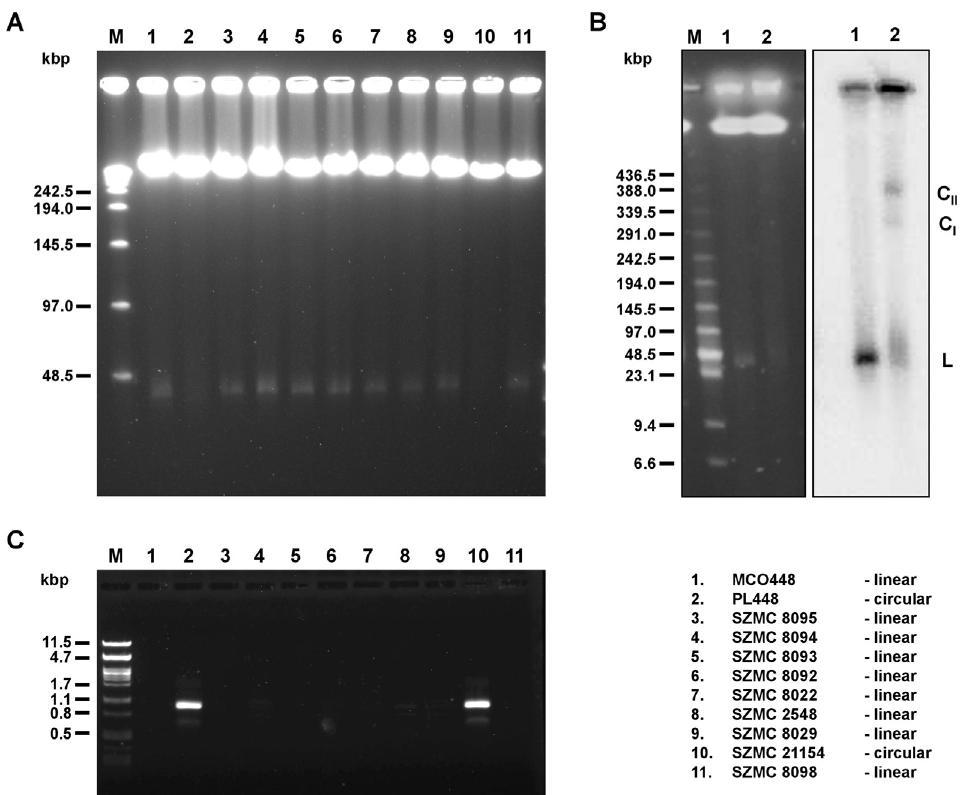
Fig 1. Linear and circular mitochondrial genomes in C . metapsilosis isolates. (A) PFGE analysis. DNA was isolated in agarose blocks and separated in PFGE as described in Materials and Methods. Only strains containing linear mitochondrial genome show a sharp band about 25 – 30 kb long. (B) Southern blot analysis. PFGE separated DNA samples were blotted onto a nylon membrane and hybridized with radioactively labeled mtDNA probe. The probe hybridizes with a sharp band (L) in the strain MCO448 with linear mtDNA (lane 1). In the strain PL448 with circular mtDNA (lane 2) the probe reveals a smeary band (23 – 100 kb) plus two fractions (labeled as CI and CII) corresponding to presumed circular replication intermediates of mtDNA. In both strains, the probe also detected mtDNA molecules trapped in wells that contain branched mtDNA structures resulting from recombinantion processes. (C) PCR analysis. The reactions were performed with primers derived from the subtelomeric genes nad3 and atp6 (localized at opposite ends and oriented toward the termini of linear molecules) on total DNA templates and the PCR products were electrophoretically separated. Only strains with circular mitochondrial genome (PL448 and SZMC21154) exhibit a PCR product derived from the end-to-end junction of the mitochondrial genome. MCO448 (lane 1), PL448 (lane 2), SZMC8095 (lane 3), SZMC8094 (lane 4), SZMC8093 (lane 5), SZMC8092 (lane 6), SZMC8022 (lane 7), SZMC2548 (lane 8), SZMC8029 (lane 9), SZMC21154 (lane 10), SZMC8098 (lane 11). M-molecular marker (Lambda Ladder PFG Marker (New England Biolabs) (in A), Low Range PFG Marker (New England Biolabs) (in B), lambda DNA/PstI (in